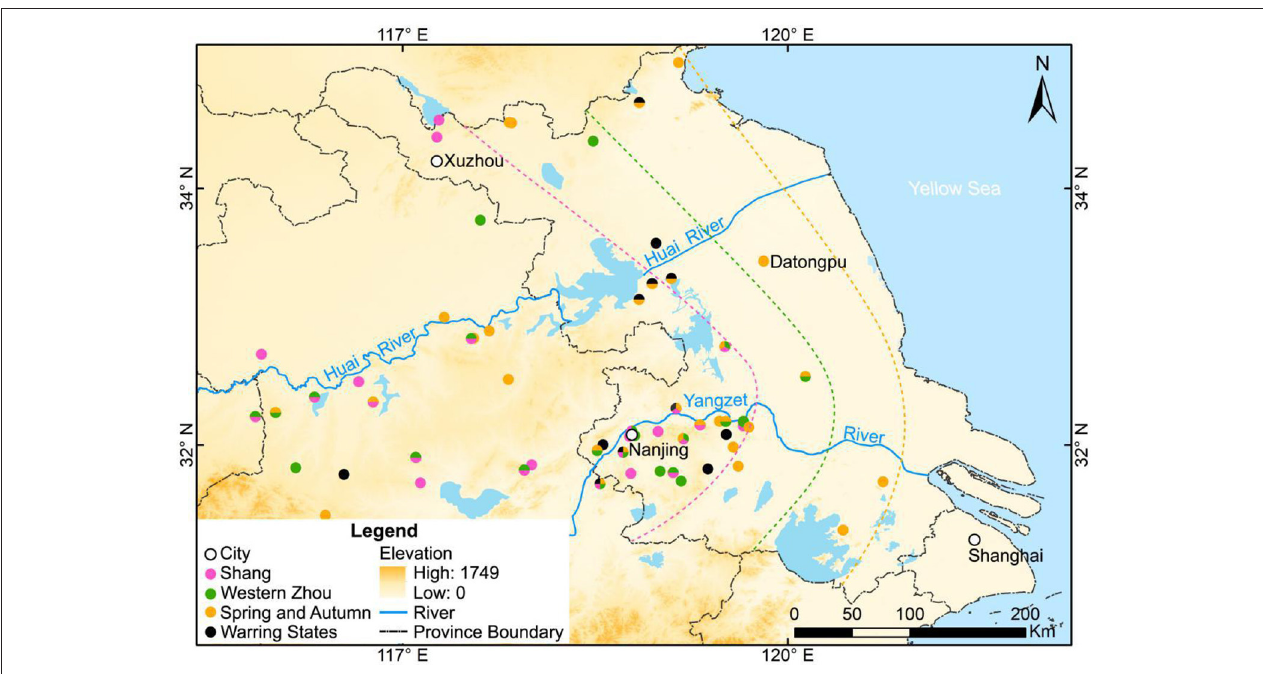
FIGURE 5 | A “waves of advance” diffusion model of the typical artifact “ Li ” from the Central China to the coastal area during the Shang-Zhou Period (The Li diffused from the Shang Dynasty to Spring and Autumn Period and probably represented the cultural expansion and human migration from the northwest to the southeast in the Jianghuai Region, which might be related to the coastline and the gradual opening of the coastline for agricultural